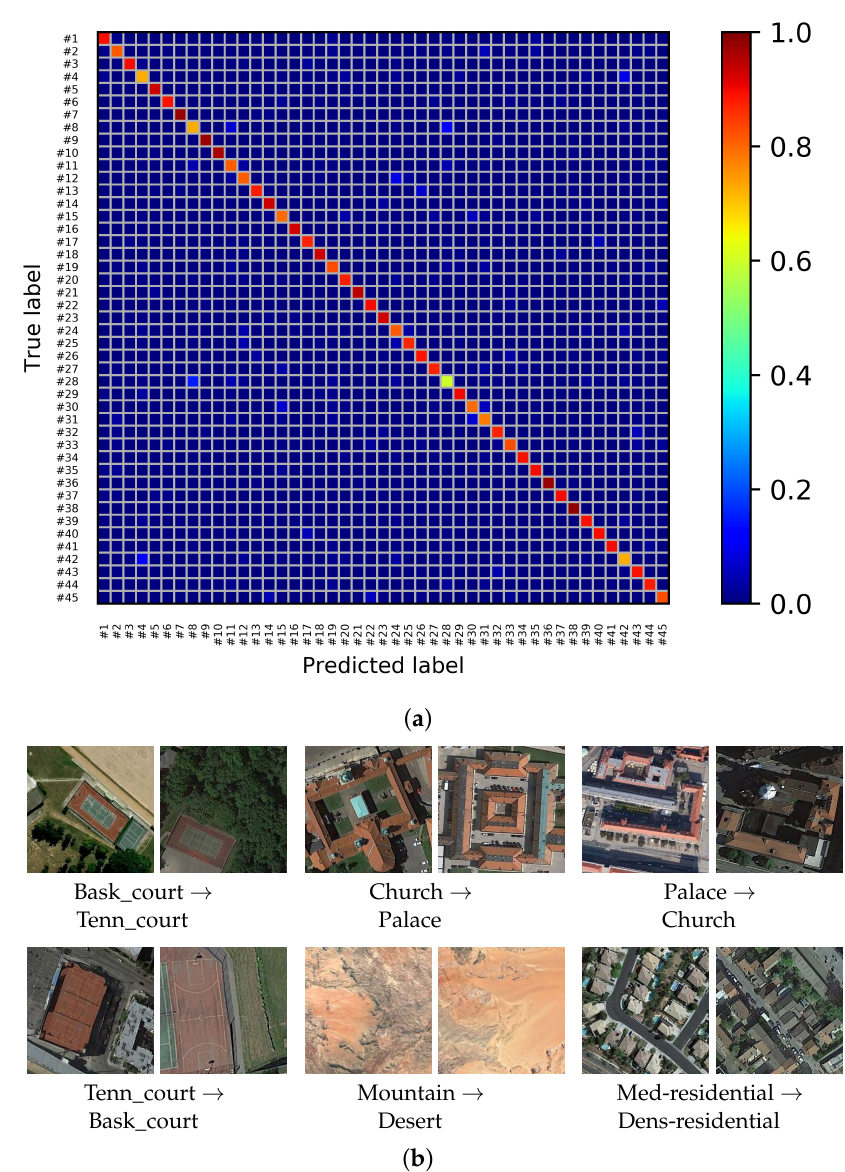
Figure 10. Confusion matrix and some misclassification examples for the NWPU dataset using the proposed MDFR architecture. ( a ) Confusion matrix of the NWPU dataset with OA = 86.89%. ( b ) Some misclassified samples of the NWPU dataset.